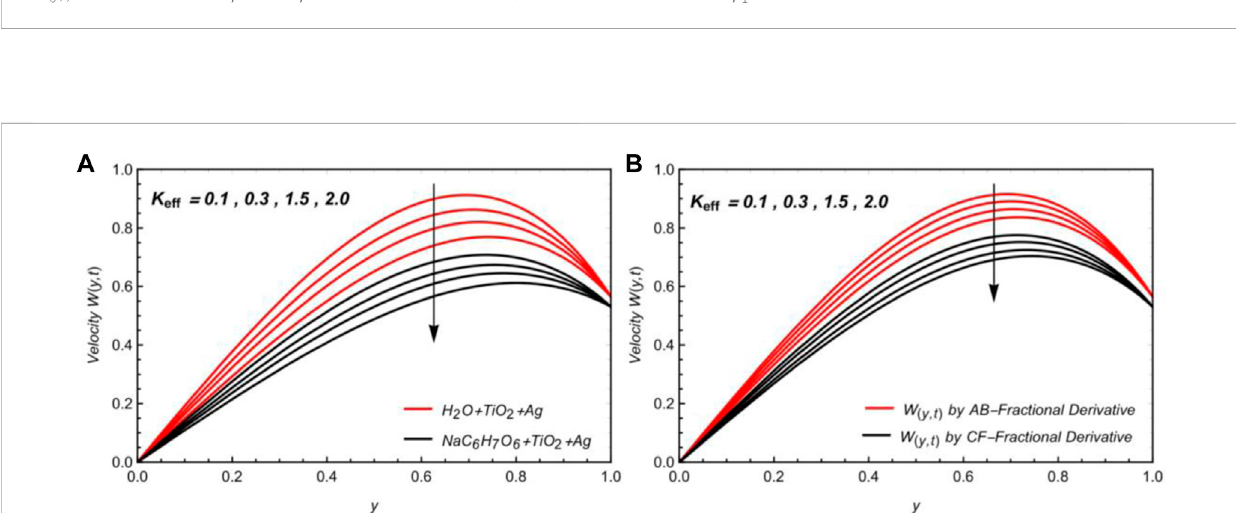
FIGURE 5 W ( y , t ) due to variation in φ with α , β (cid:2) 0 . 5 , M (cid:2) 1 . 65 , Ra (cid:2) 1 . 2 , K eff (cid:2) 0 . 7 , Gr (cid:2) 8 . 0 , Gm (cid:2) 6 . 3 , β 1 (cid:2) 1 . 5 , θ (cid:2) π /4 , and t (cid:2) 0 . 8.